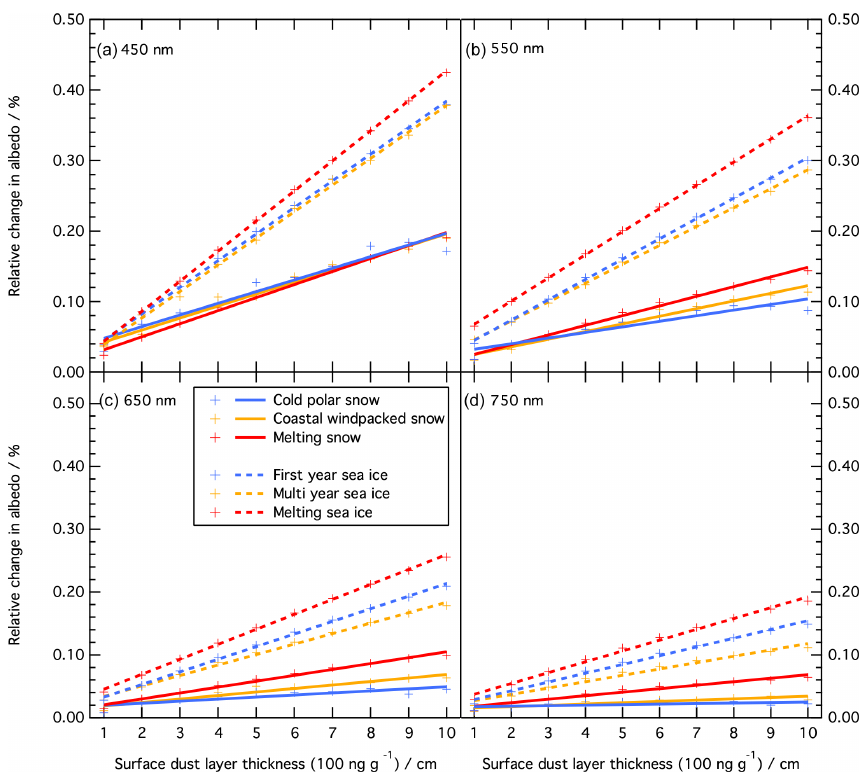
Figure 9. Relative change in albedo for an increasing surface layer of 100ngg − 1 of mineral dust between 1cm and 10cm at 450 (a) , 550 (b) , 650 (c) and 750nm (d) . The albedo without a surface layer is 0.996 at 450nm, 0.988 at 550nm, 0.973 at 650nm and 0.950 at 750nm for cold polar snow, 0.989 at 450nm, 0.980 at 550nm, 0.957 at 650nm and 0.920 at 750nm for coastal windpacked snow, 0.943 at 450nm, 0.932 at 550nm, 0.892 at 650nm and 0.815 at 750nm for melting snow, 0.611 at 450nm, 0.575 at 550nm, 0.452 at 650nm and 0.267 at 750nm for first-year sea ice, 0.950 at 450nm, 0.866 at 550nm, 0.721 at 650nm and 0.542 at 750nm for multi-year sea ice and 0.505 at 450nm, 0.412 at 550nm, 0.215 at 650nm and 0.079 at 750nm for melting sea